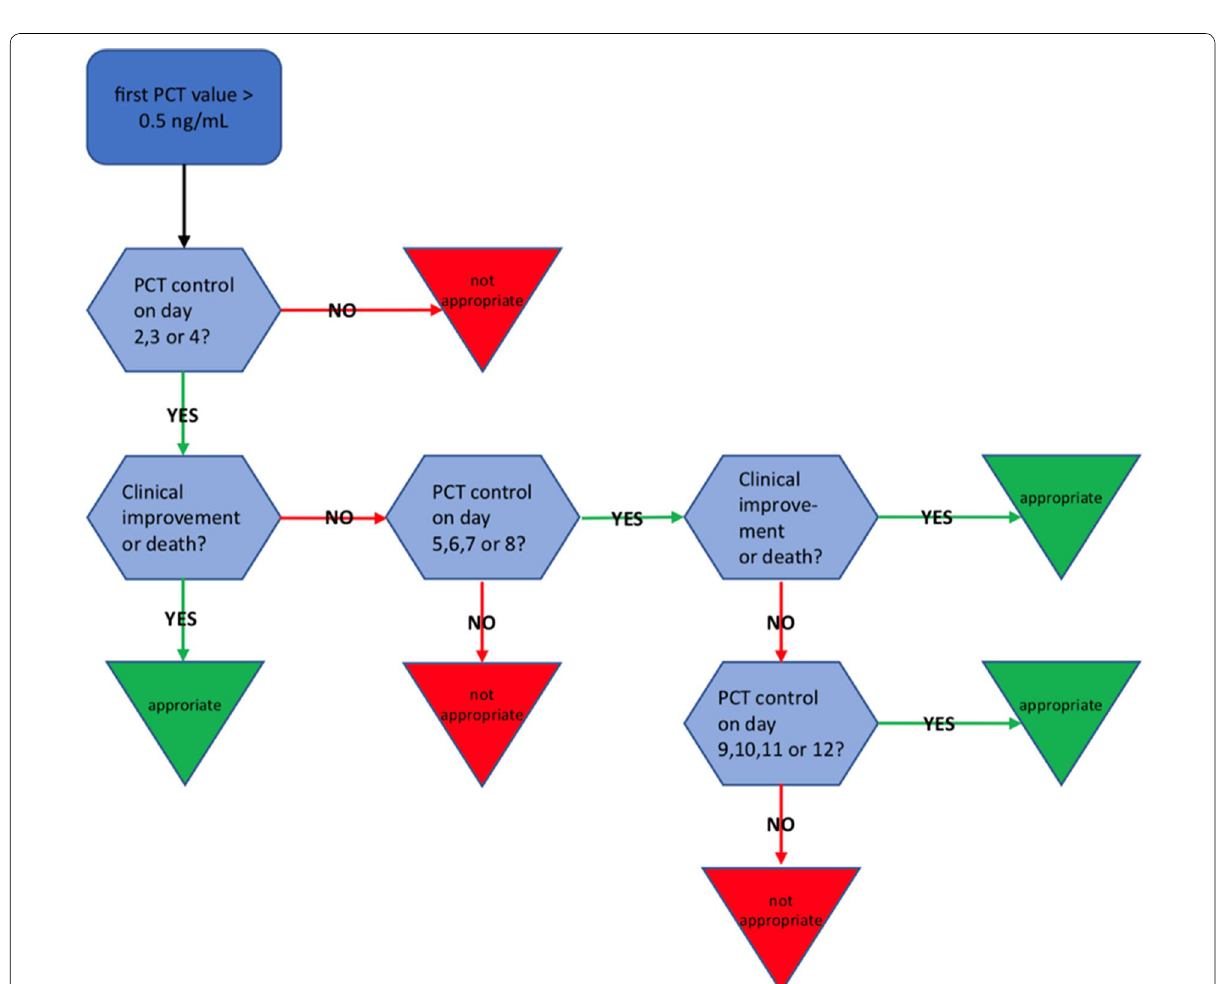
Fig. 1 Selection algorithm to identify patients with appropriate procalcitonin (PCT) measurement series according to